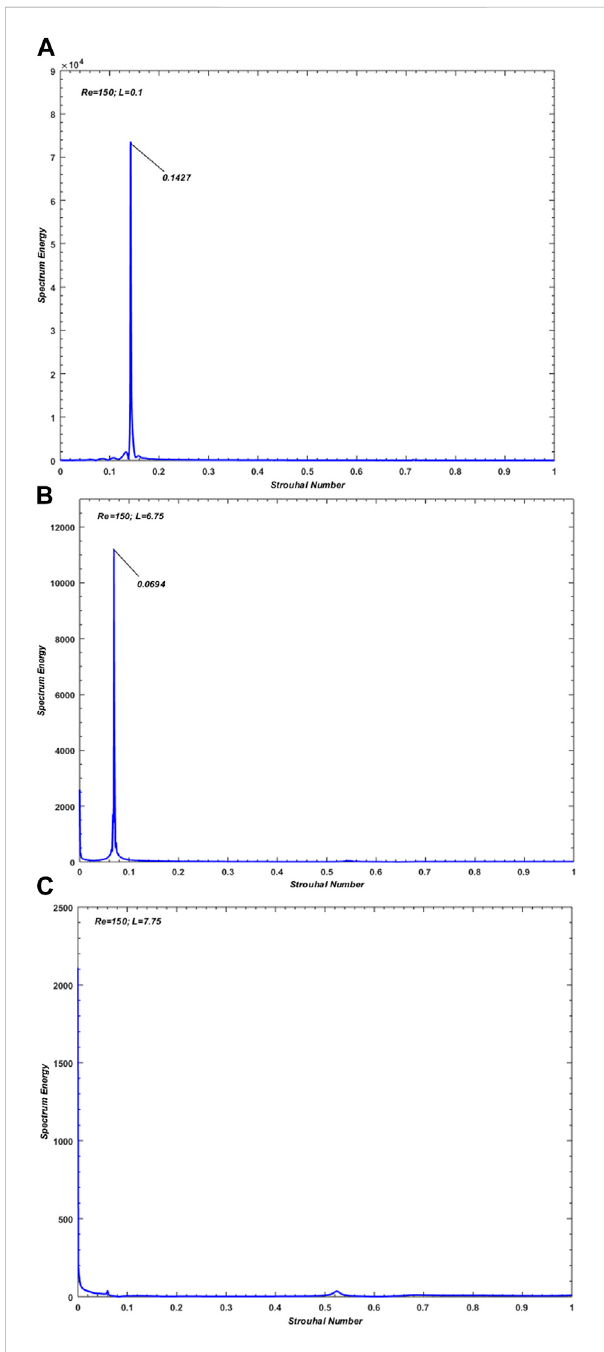
FIGURE 8 Power Spectrum graphs corresponding to different fl ow modes: (A) Unsteady, (B) Tranisent, and (C) Steady fl ow